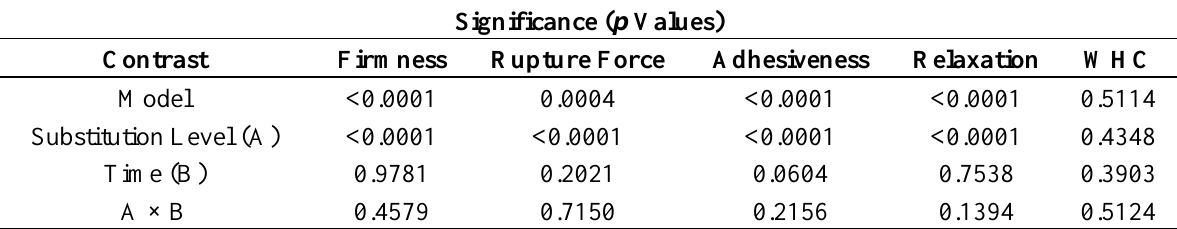
Table 1. Summary of the significance of the effects of powdered whey:buttermilk aggregate (WBAP) and time on the texture and water-holding capacity of yogurt gels, as calculated by analysis of variance ( n =